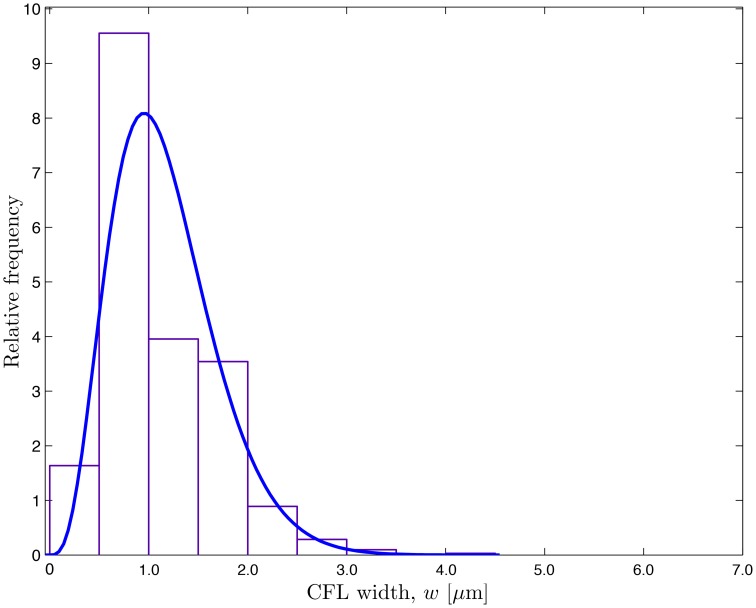
Frequency distribution of the temporally fluctuating CFL width w reported by Ong et al. (2011a) and the fitted β-distribution.